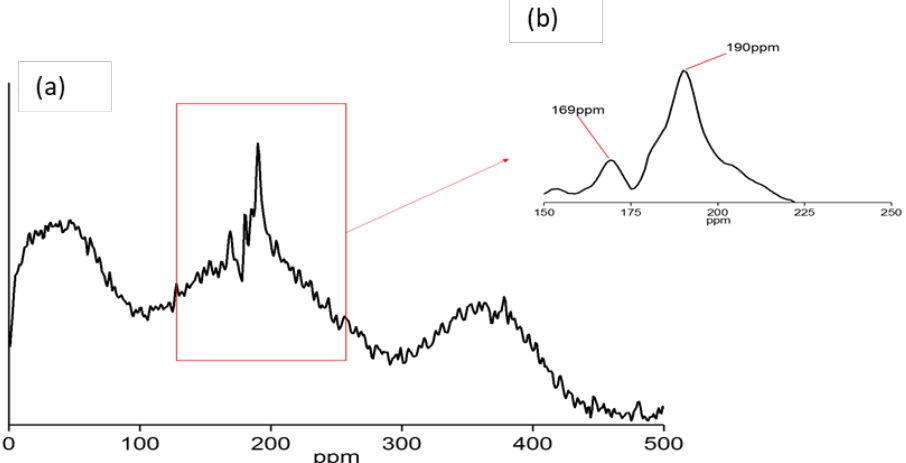
Figure 8. 29Si NMR of CTS-Si/HNT where ( a ) peak at 500 ppm magnification and ( b ) peak at 200 ppm magnification.